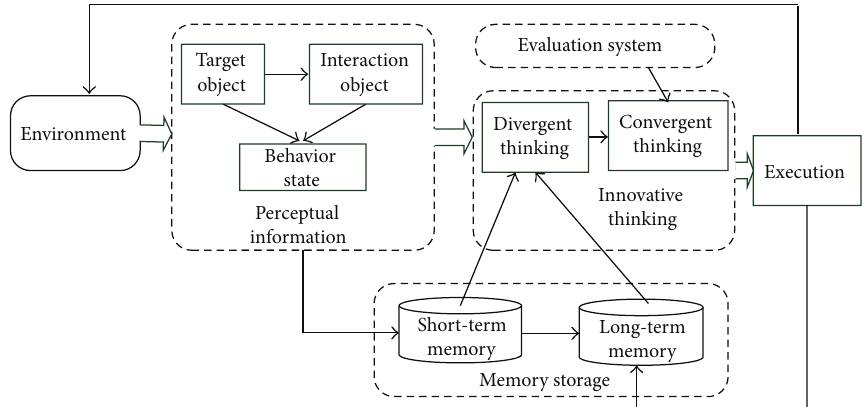
Figure 1: The basic framework and the relationship of the five parts of ITIIF